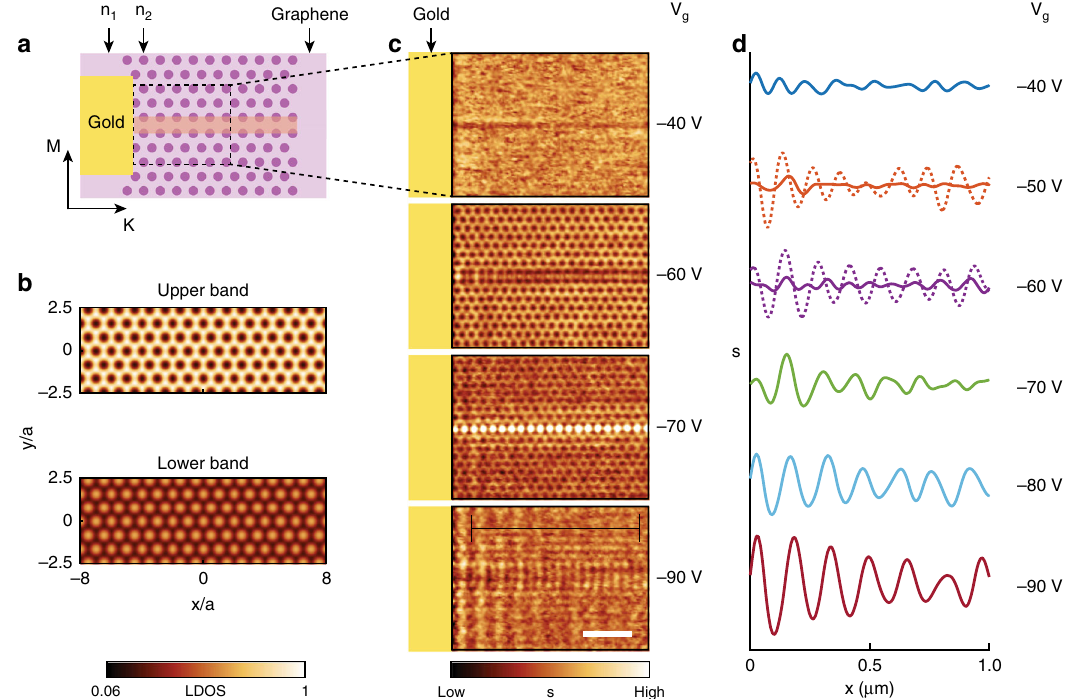
Fig. 2 Gate-tunable plasmonic response of a graphene-based photonic crystal. a Schematic of the photonic crystal structure with an engineered domain wall in the middle, highlighted in orange. Color contrast represents carrier density modulation n 1,2 in graphene. A gold antenna in the left serves as a plasmon launcher. The scanned area in panel c is marked with a dashed box. K/M directions in BZ are marked with arrows. b Simulated LDOS maps for upper and lower plasmonic bands. c Experimental near- fi eld images s ( r , ω ) acquired at different gate voltages at T = 60 K and laser frequency ω = 904 cm − 1 . At V g = − 40 V, only faint plasmonic fringes are observed. At V = − 60 V, a hexagonal pattern of dark spots emerges. At V = − 70 V, a 1D domain wall state g g appears in the middle of the image. At V g = − 90 V, propagating plasmons are launched by the gold antenna on the left. This latter image also reveals a hexagonal pattern of bright spots. Black solid line marks the location of the line pro fi les in panel d . Scale bar: 400 nm. d Line pro fi les s ( r , ω ) taken in the photonic crystal region away from the domain wall. Dotted lines display the corresponding line pro fi les in un-patterned region. The systematic increase of ffiffiffi p v n SPP wavelength λ p with carrier density n s matches the expected scaling: λ F s ϵ ω p /